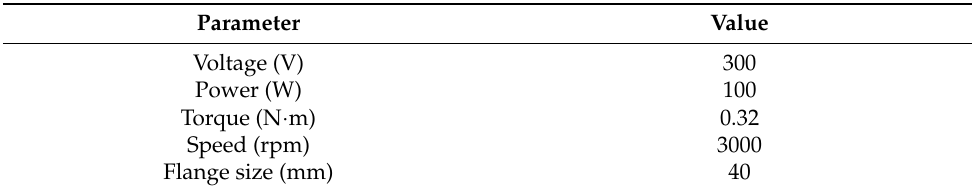
Table 7. Technical Specification of Servo